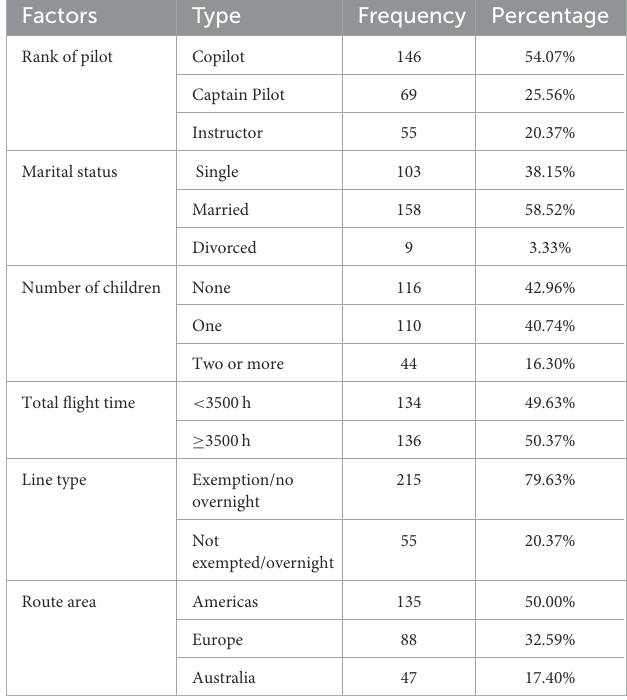
TABLE 1 Statistical analysis of pilots’